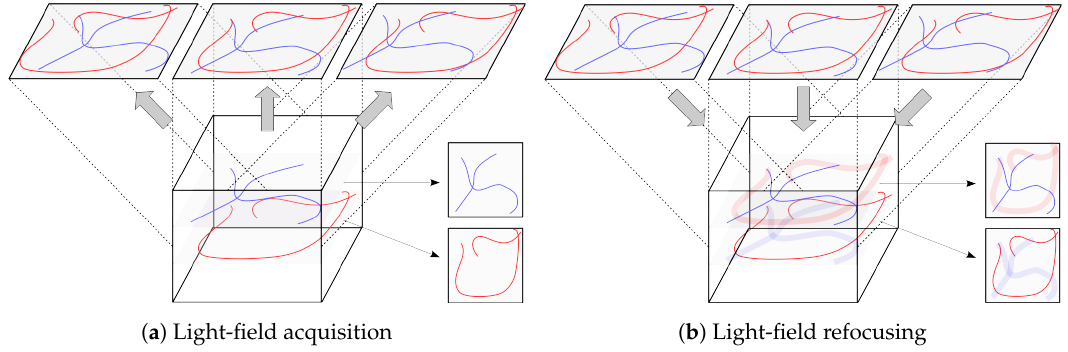
Figure 2. Sketch of traditional light-field operations: ( a ) light-field acquisition from the illuminated volume; and, ( b ) integration refocusing (shift-and-add) of the focal stack. Sharp in-plane structures are superimposed with blurry out-of-plane